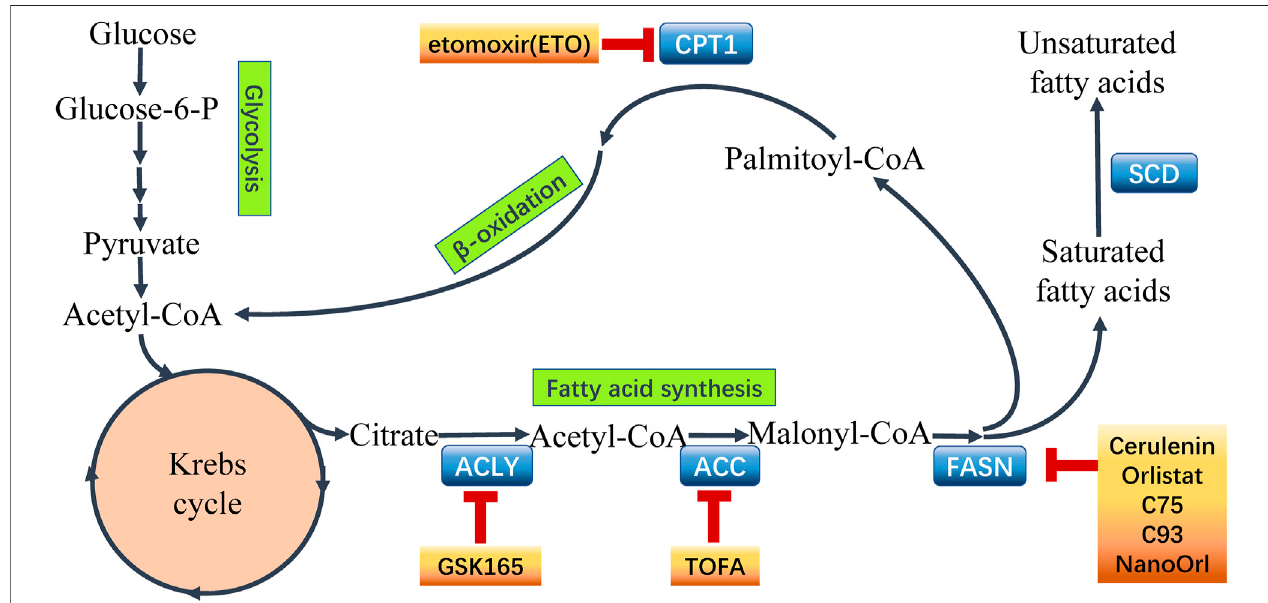
FIGURE 2 | Fatty acid metabolism and points of intervention to overcome chemoresistance. Fatty acid metabolism plays a critical role in chemoresistant cancer cells. Aberrantmetabolismcontributestothe survivaland proliferationofmalignantcells. Importantly, thekeyenzymescatalyzingtheprocesses infatty acidmetabolism havebeenrecognizedtoexpressabnormallyincancerchemoresistance. Hence,itisanovelstrategyusinginhibitorstotargetthekeyenzymes tointervenetheaberrant metabolism and overcome chemoresistance in cancer. Some common inhibitors of the key enzymes are shown above. ATP-citrate lyase (ACLY), acetyl-CoA carboxylase (ACC), fatty acid synthase (FASN), stearoyl-CoA desaturase (SCD), carnitine palmitoyltransferase 1